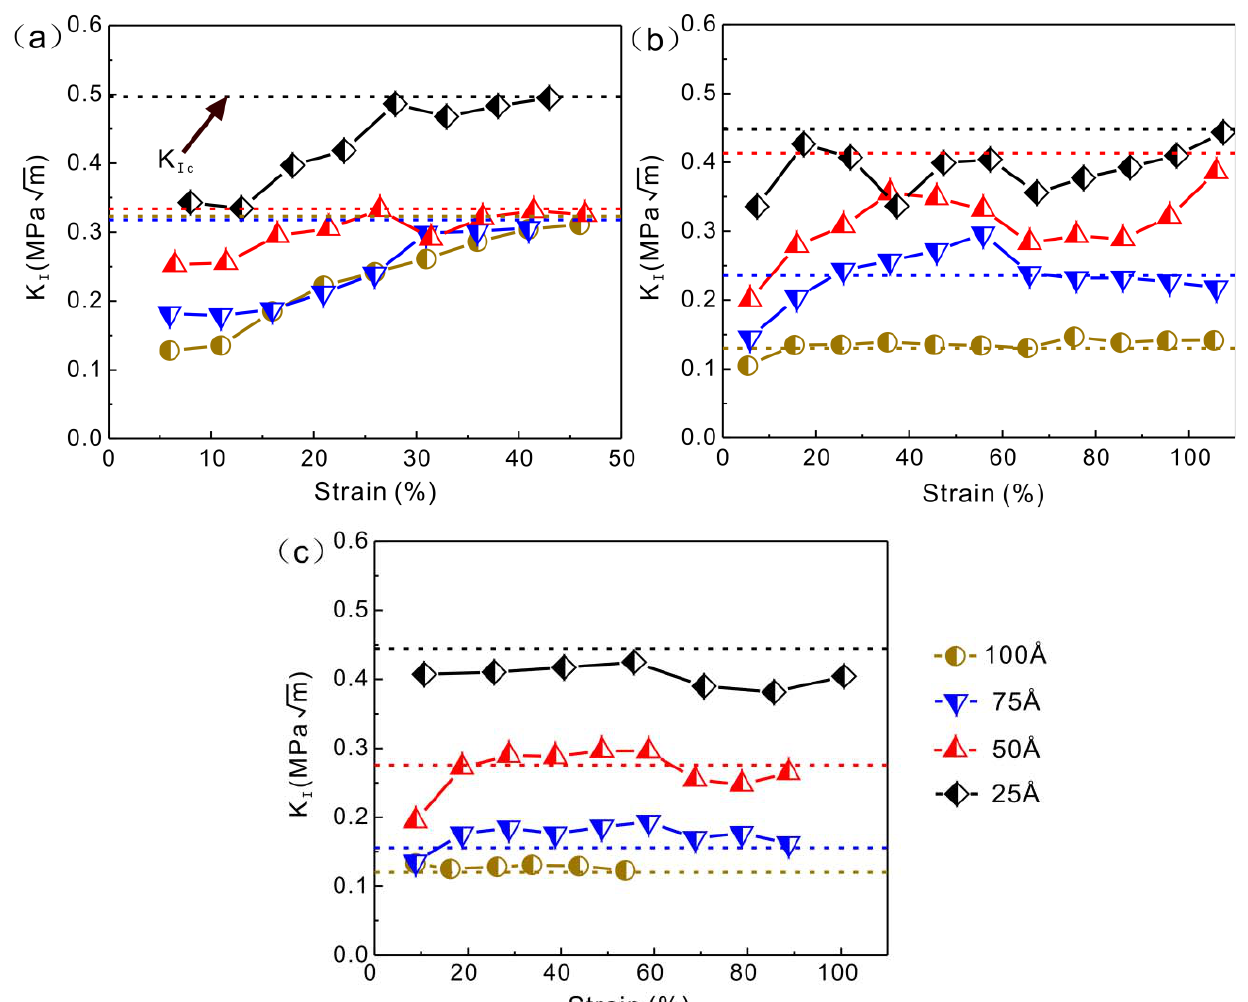
Figure 3. Stress intensity factor and critical stress intensity factor (dashed line) for Cu nanowires with different initial crack depths ( a ) 1 × 10 8 s − 1 , ( b ) 5 × 10 8 s − 1 , ( c ) 5 × 10 9 s − 1